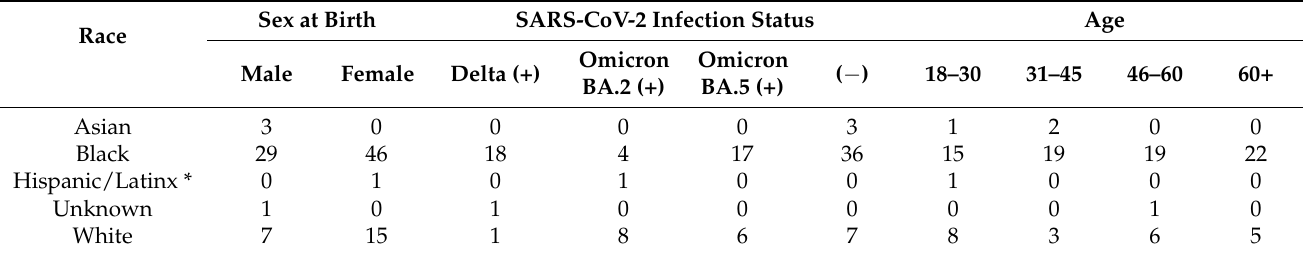
Table A1. Demographic Breakdown of